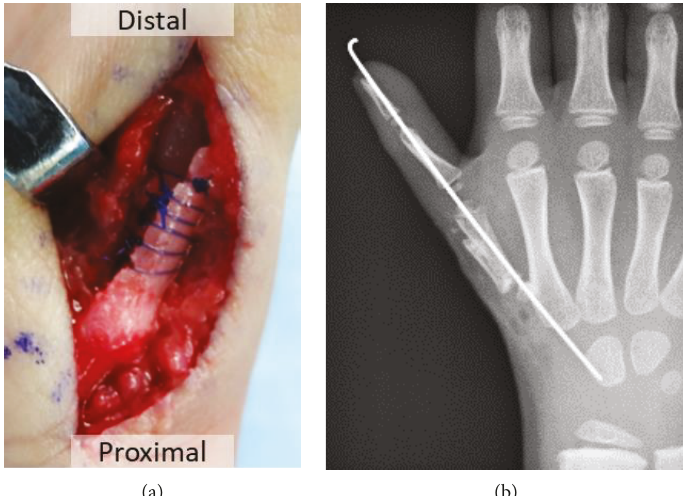
Figure 4: The metatarsal bone transplanted into the metacarpal bone. (a) The metacarpal bone and the cut metatarsal bone were sutured. (b) These were fi xed with a Kirschner wire.